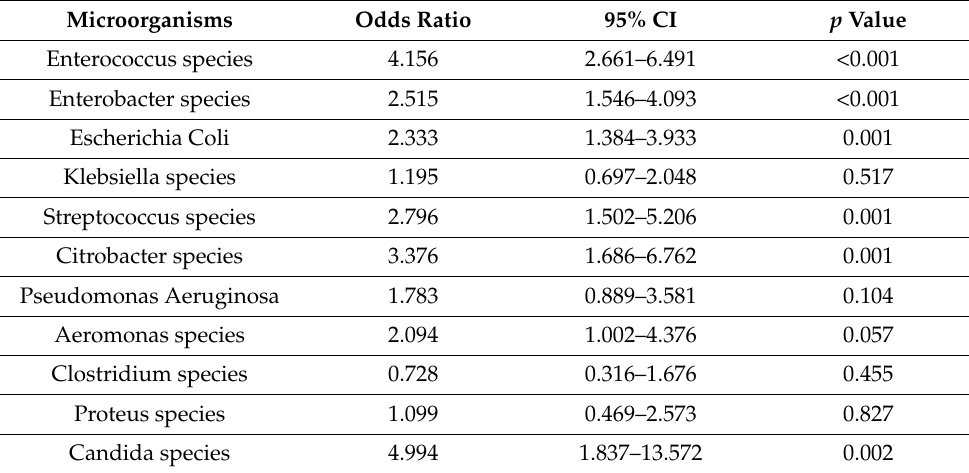
Table 2. Statistical analysis of microorganisms to predict intra-abdominal abscess.